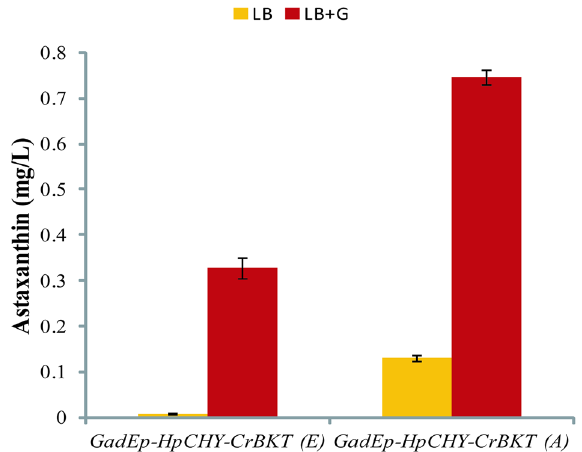
Fig. 2 Astaxanthin production of E. coli JM109 co-transformants (pACCAR16 D crtX ? pUC- GadE p- HpCHY - CrBKT (E) / (A) ) cultivated in LB with or without glucose induction. Data represent averages from three or more replicate cultures; error bars show standard deviation